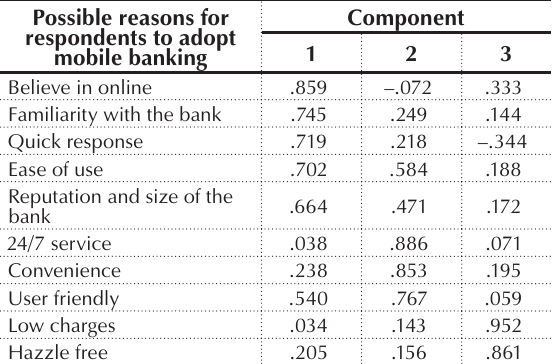
Table 1(cid:1006). (cid:87)(cid:381)(cid:400)(cid:400)(cid:349)(cid:271)(cid:367)(cid:286)(cid:3)(cid:396)(cid:286)(cid:258)(cid:400)(cid:381)(cid:374)(cid:400)(cid:3)(cid:296)(cid:381)(cid:396)(cid:3)(cid:396)(cid:286)(cid:400)(cid:393)(cid:381)(cid:374)(cid:282)(cid:286)(cid:374)(cid:410)(cid:400)(cid:3)(cid:3) (cid:410)(cid:381)(cid:3)(cid:258)(cid:282)(cid:381)(cid:393)(cid:410)(cid:3)(cid:373)(cid:381)(cid:271)(cid:349)(cid:367)(cid:286)(cid:3)(cid:271)(cid:258)(cid:374)(cid:364)(cid:349)(cid:374)(cid:336)